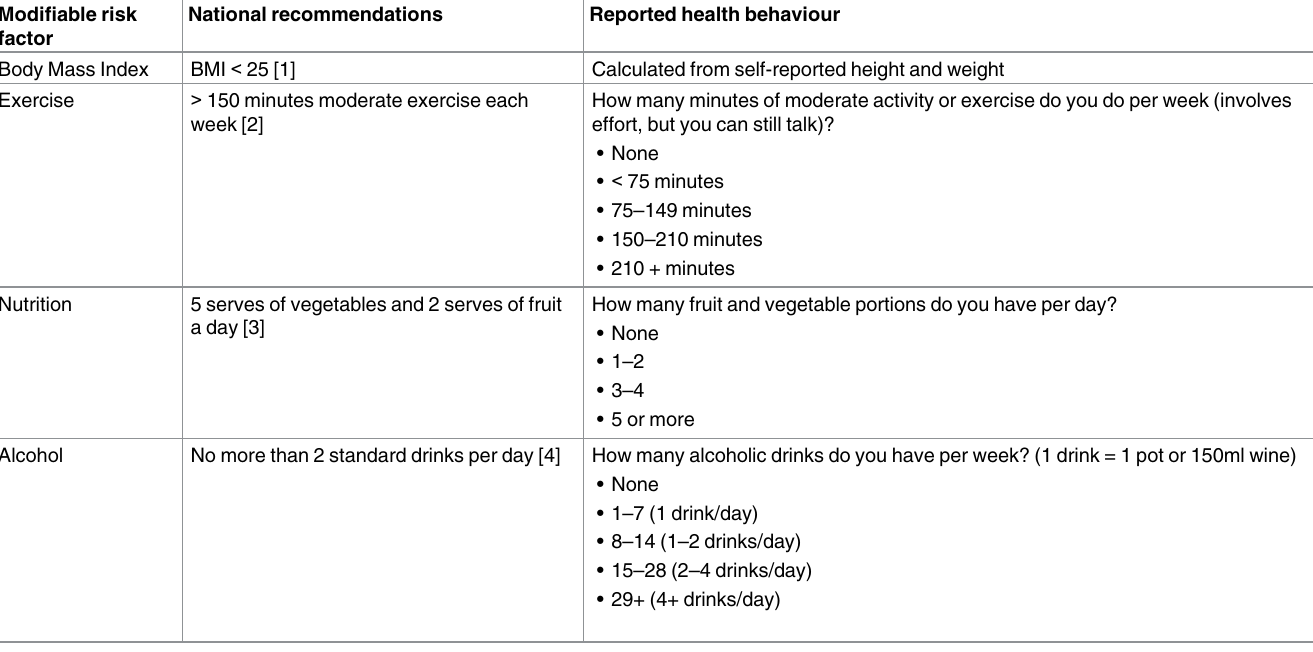
Table 1. Summaryof the Institute of Health and Welfare recommendations on lifestyle risk factors to prevent